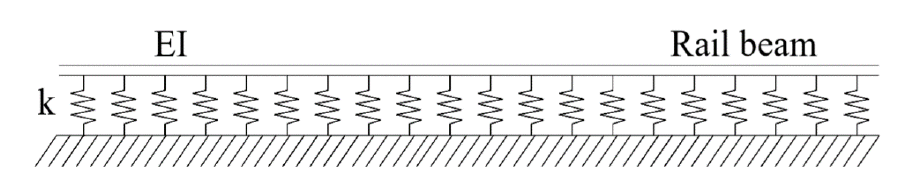
Fig. 2 . Beam on elastic foundation